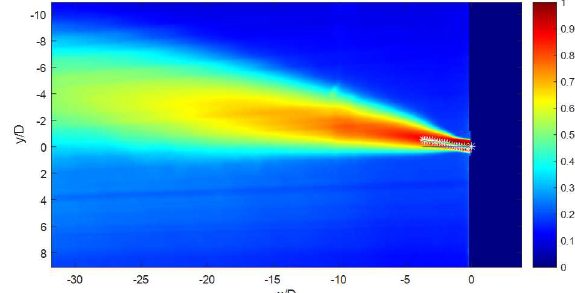
Fig. 8. Mean non-dimensional concentration C/C 0 field ( C 0 is the mean concentration measured at the outlet, i.e. the initial jet concentration) for a jet with r = 0.103 ( θ ≈ 8°); the white asterisks are the concentration maxima in the initial region of the jet, the green line is the jet axis, the blue line is the line perpendicular to the pipe axis.